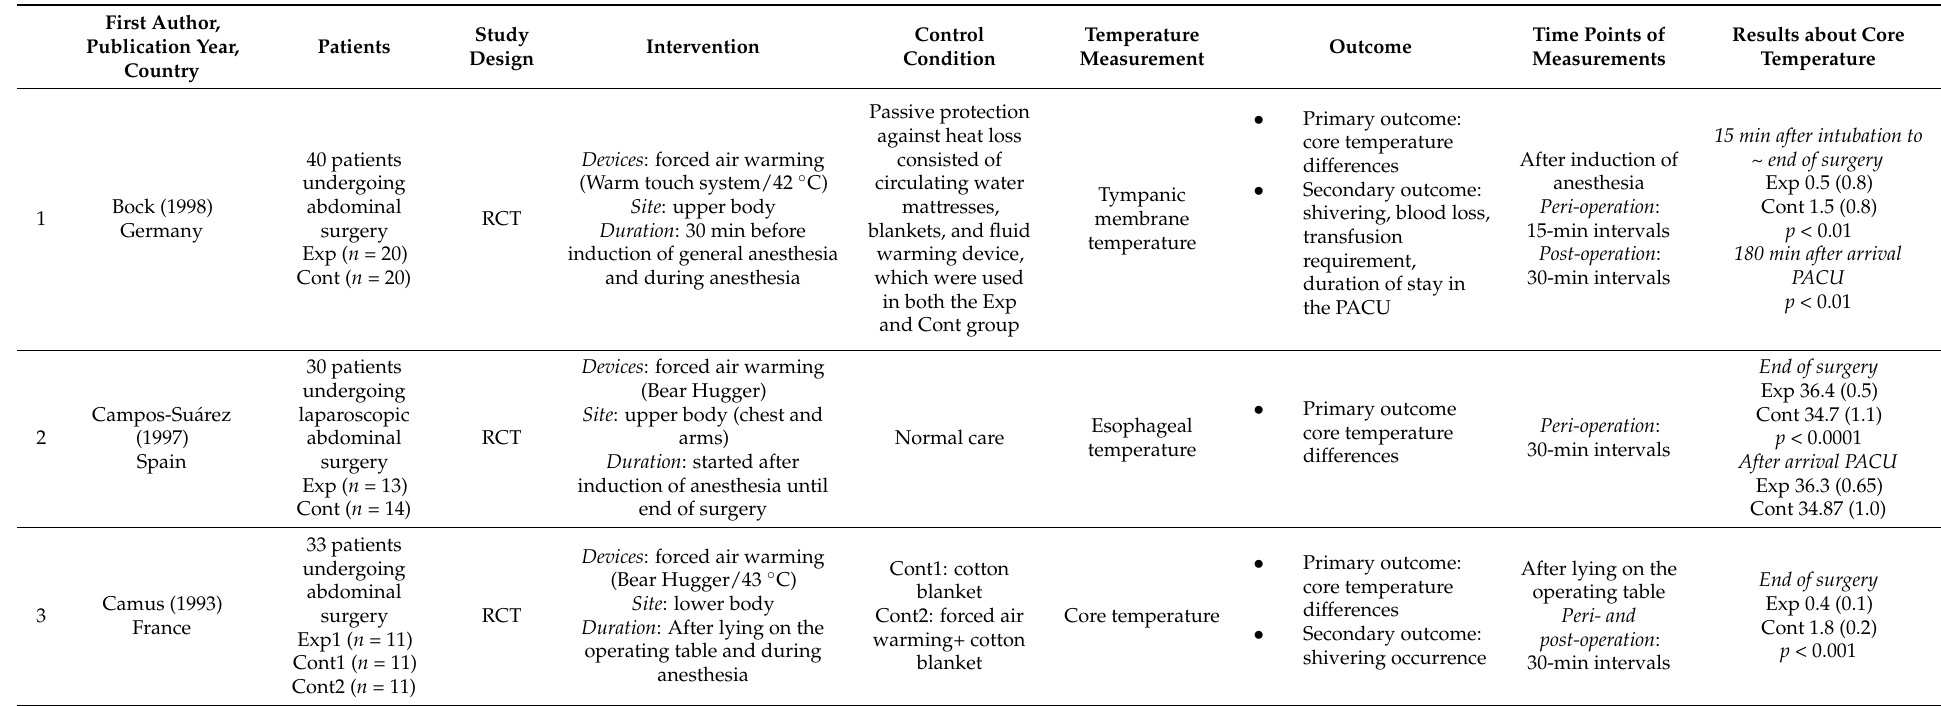
Table 1. Descriptive summary of included